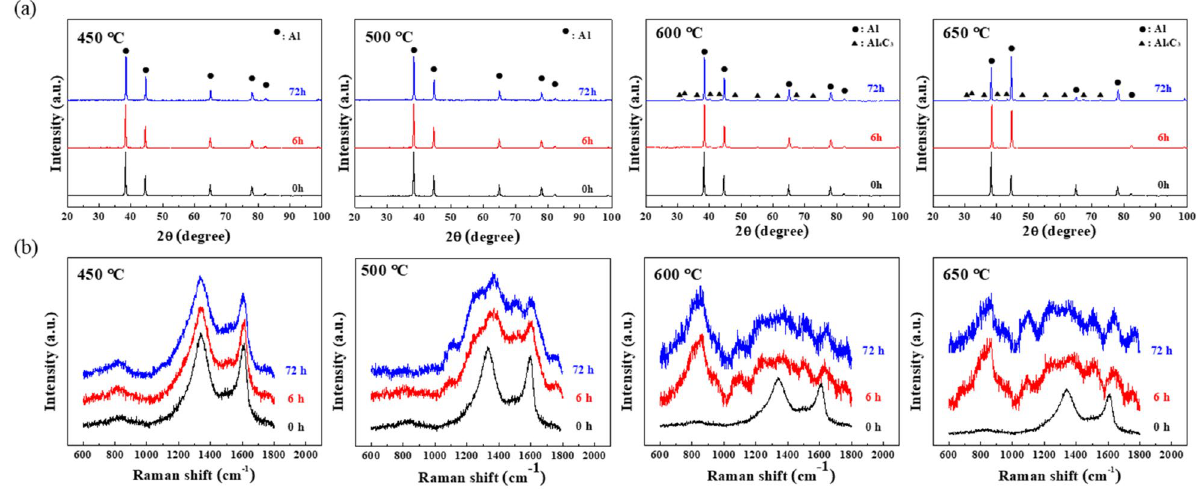
Figure 4. ( a ) XRD patterns and ( b ) Raman spectra of of Al/C60 nanocomposites after heat treatment at various temperatures for 6 and 72